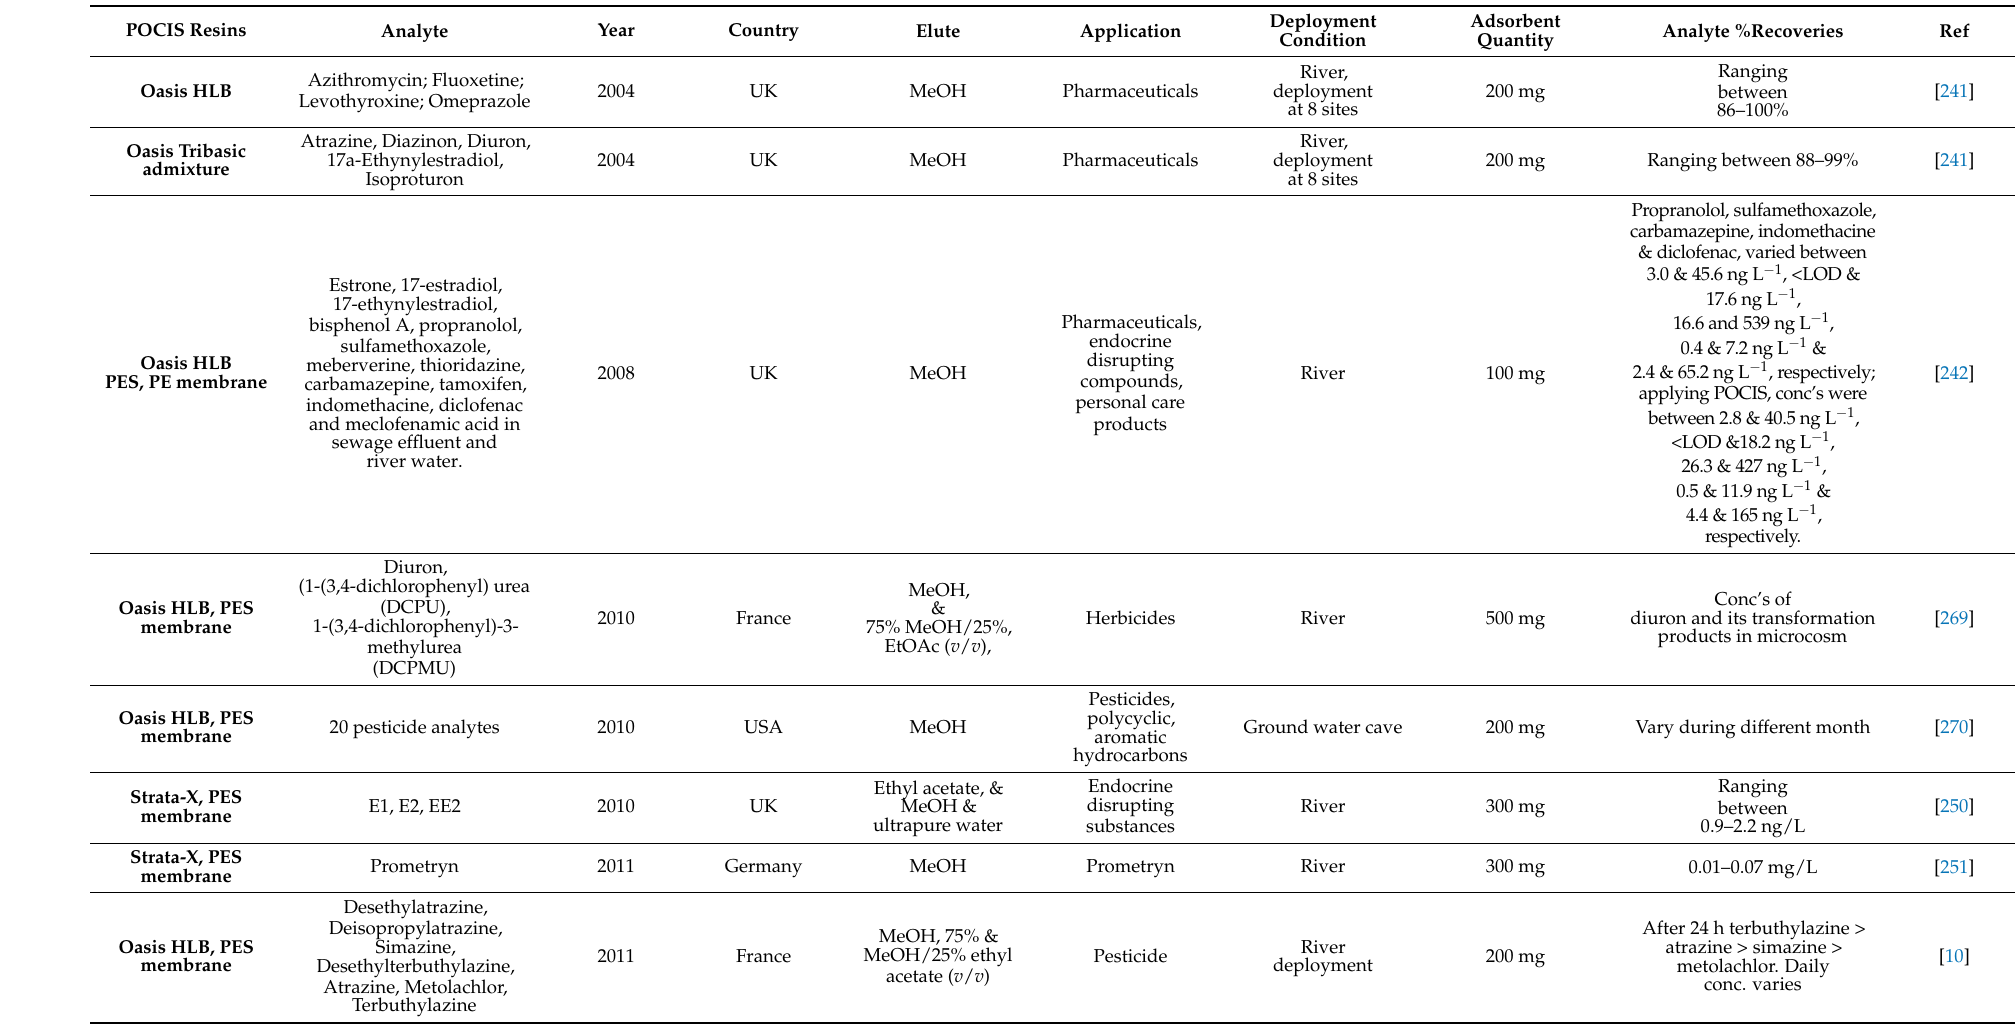
Table 8. Application of POCIS to river water